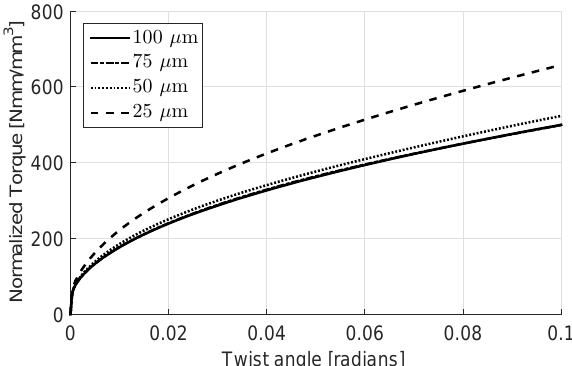
Figure 5. Torque vs. twist angle curves with varying disc